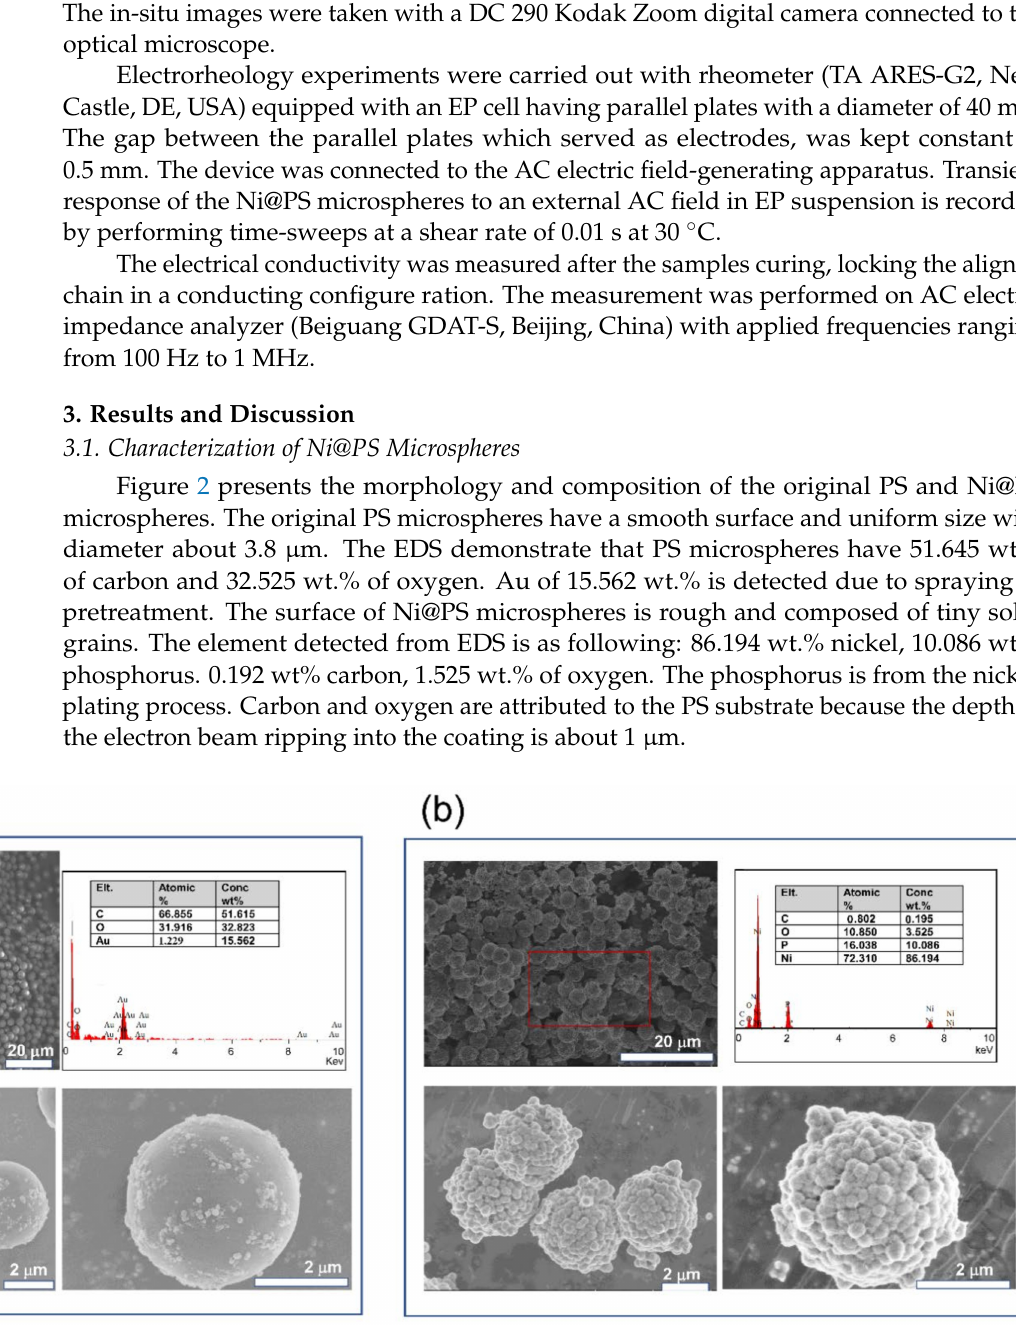
Figure 2. Surface morphology of ( a ) original PS, and ( b ) Ni@PS microspheres by